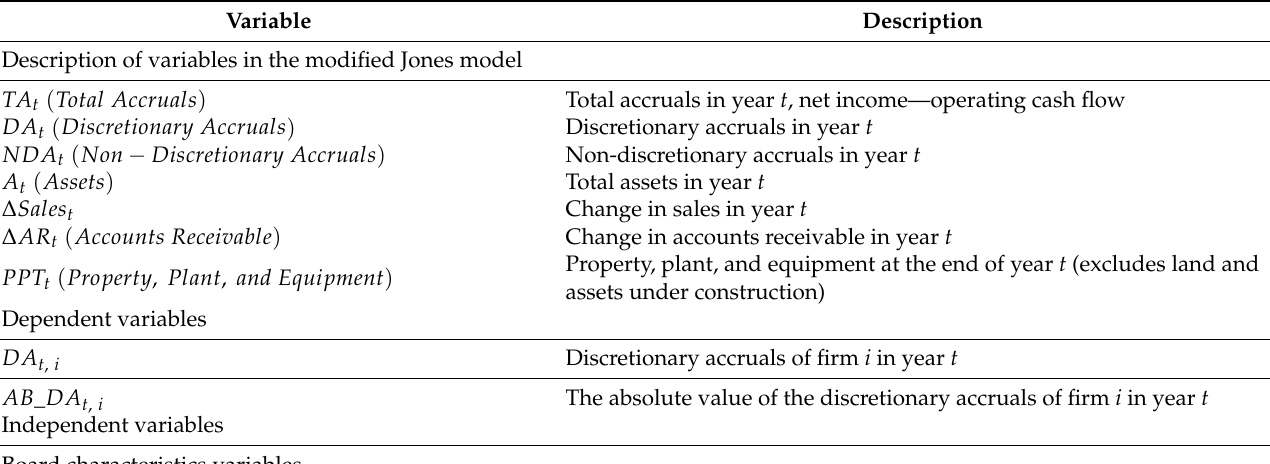
Table A1. Definition of